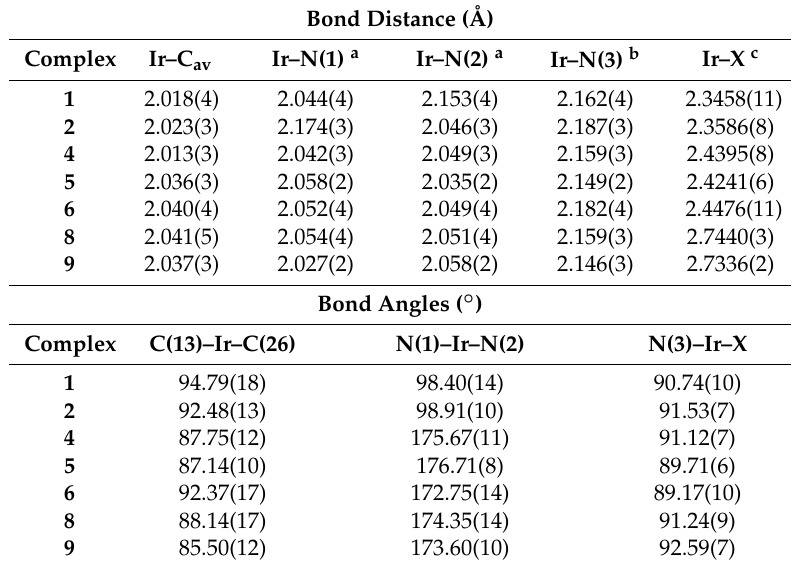
Table 1. Selected Bond Distance (Å) and Bond Angles for Complexes 1 , 2 , 4 – 6 , and 8 – 9 .